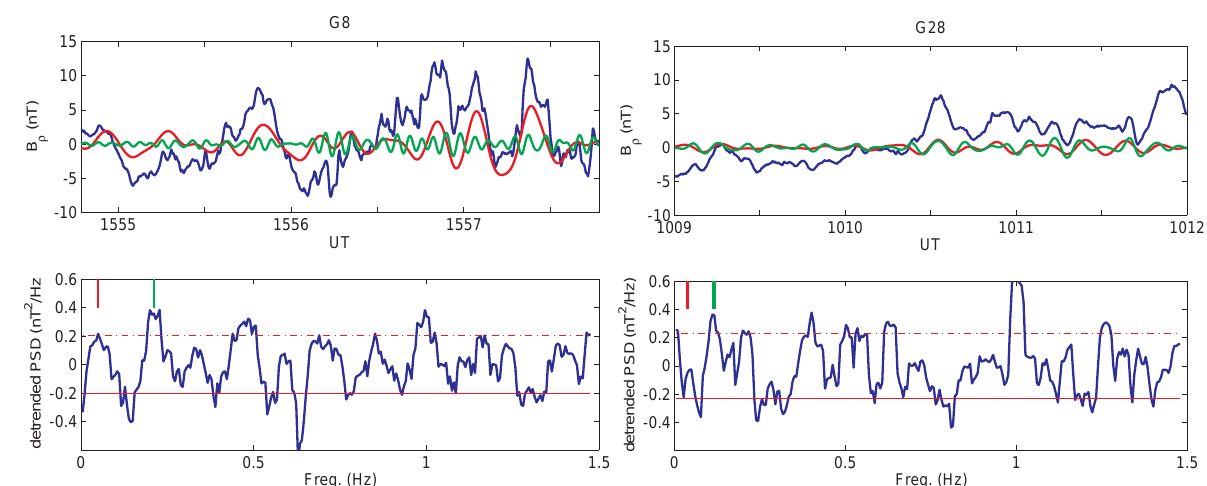
Fig. 3. Left panels: At the bottom the detrended (third-order polynomial) power spectra for the FLRs in the G8 flyby are shown. The dashed and solid horizontal red lines show the 95% confidence levels. The small red and green lines show the location of the first and second harmonics. The top panel shows one of the transverse magnetic field components ( B ρ in blue with the band-pass filtered data for the first (red) and second (green) harmonics). Right panels: the same for G28.